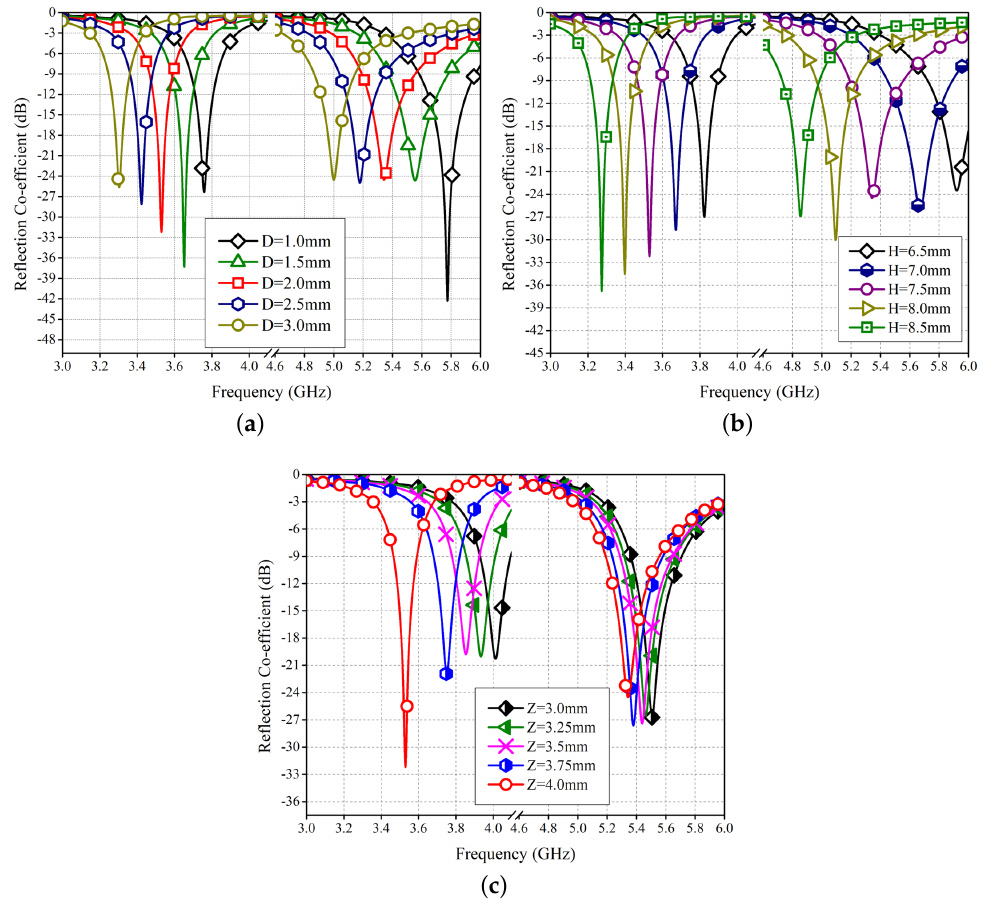
Figure 4. Effect of design parameter ( a ) D, ( b ) H, and ( c ) Z on antenna’s reflection